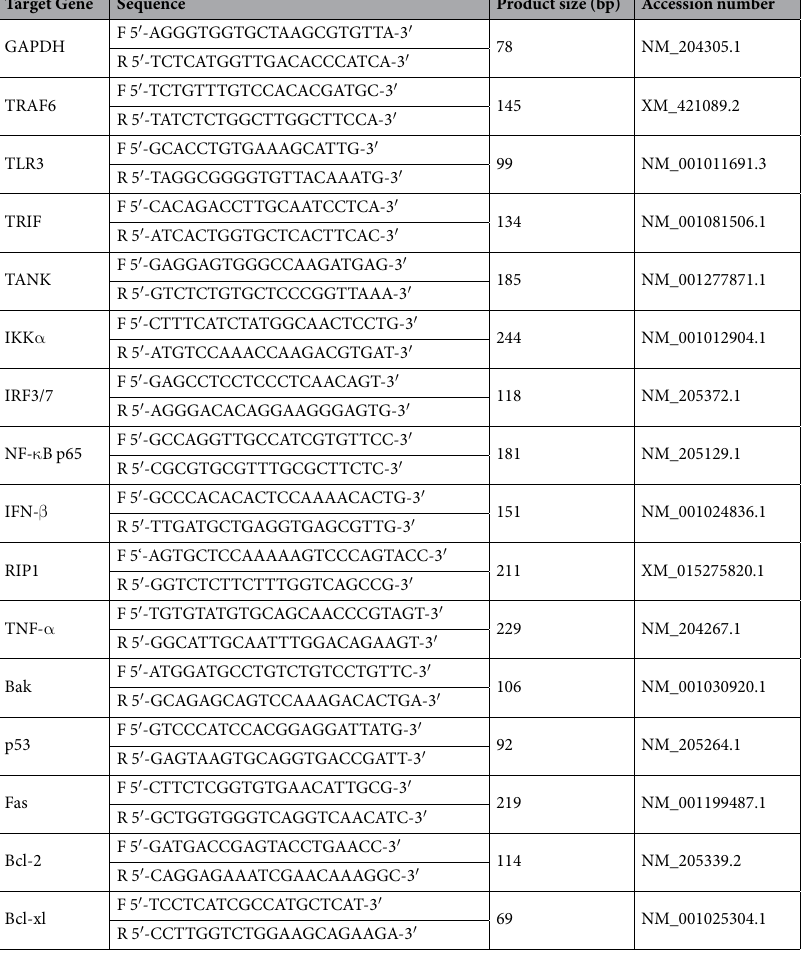
Table 1. Primers used for real-time